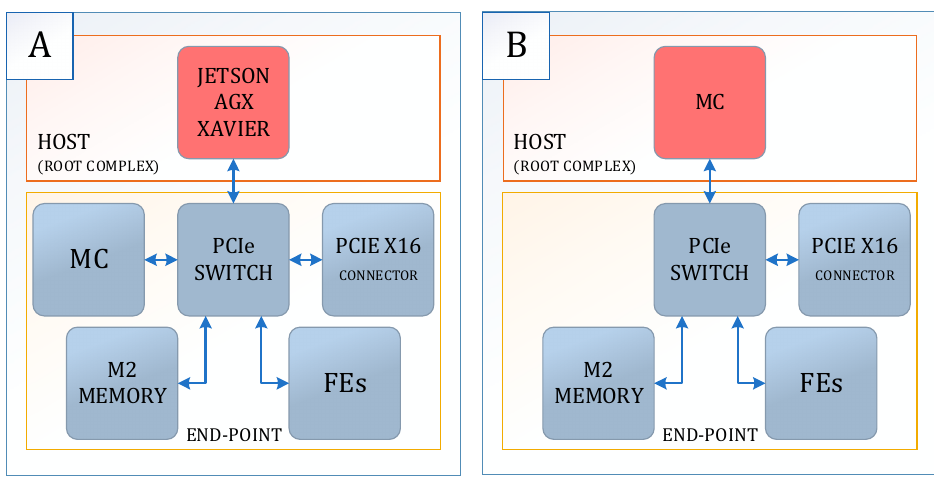
Figure 5. The single host architecture with 2 different Root Complex (Host) scenarios: ( A ) with Jetson AGX Xavier and ( B ) with Master Control (MC) board.